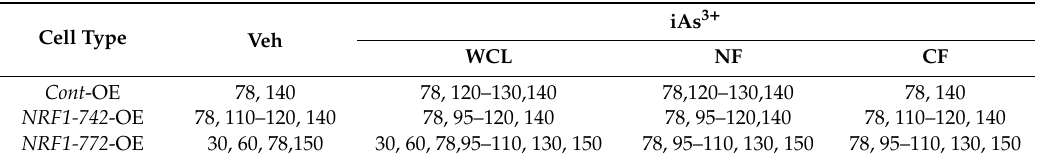
Table 1. Subcellular localization of NRF1-742 and NRF1-772 proteins and their derivative bands under normal or iAs 3+ treatment conditions.